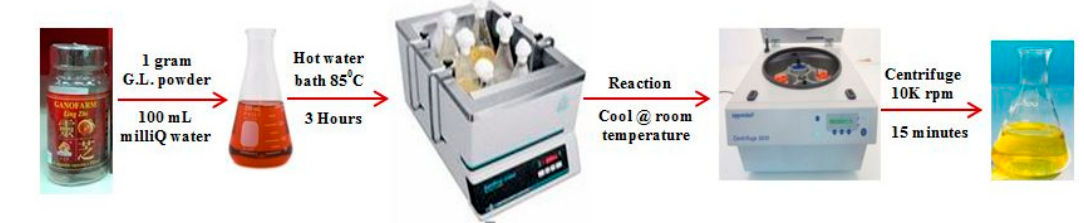
Figure 2. Schematic illustration of preparing Ganoderma lucidium extract.